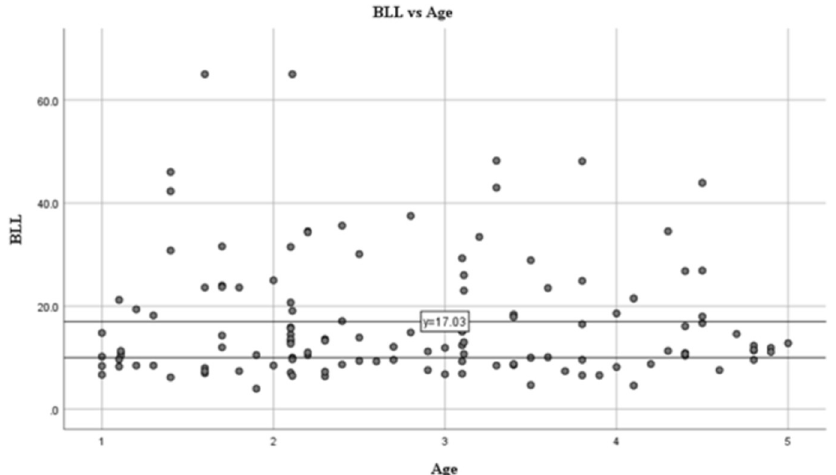
Fig 2. Blood lead level distribution among the subjects based on age